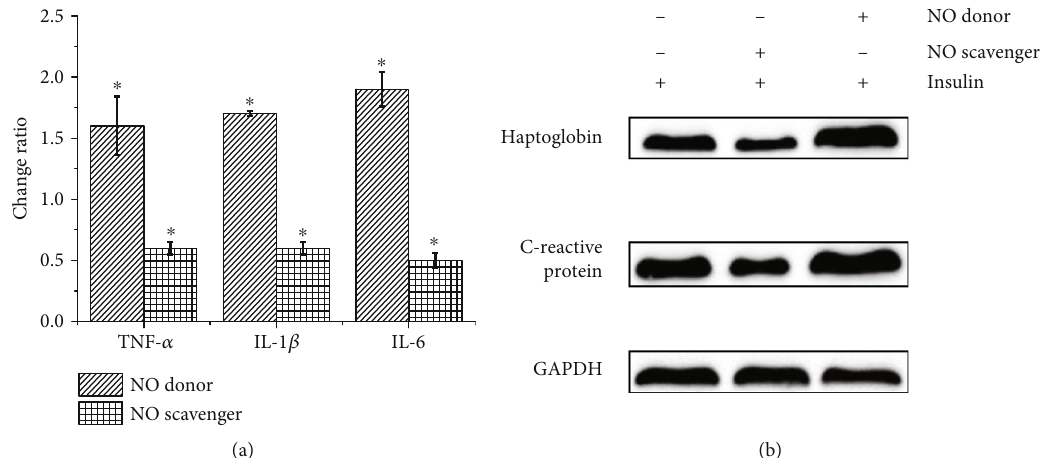
Figure 2: The in fl ammatory factor levels in HepG2 cells. (a) The ratio of TNF- α , IL-1 β , and IL-6 contents in insulin-induced HepG2 cells treated with NO donor or NO scavenger and TNF- α , IL-1 β , and IL-6 contents in untreated insulin-induced HepG2 cells. (b) Western blot detects the C-reactive protein and heptoglobin expression in insulin-induced HepG2 cells after di ff erent